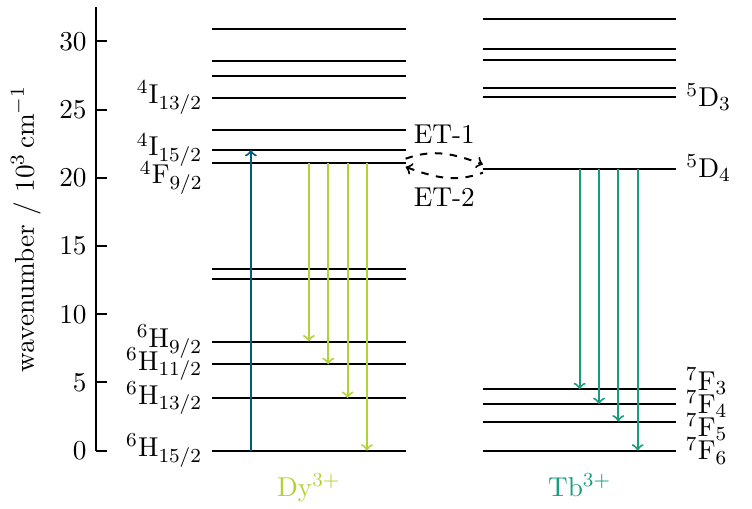
Figure 7. Energy level diagrams depicting the 452-nm excitation route of Dy 3 + (blue arrow) and the routes for radiative emissions from the 4 F 9/2 level of Dy 3 + and the 5 D 4 level of Tb 3 + . The dashed arrows indicate the energy transfer from Dy 3 + to Tb 3 + , and vice